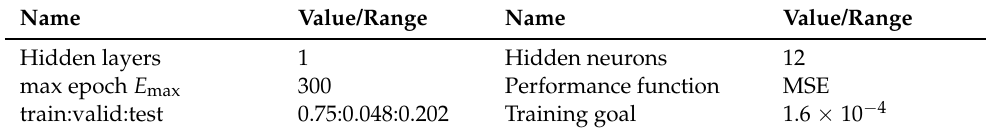
Figure 7. Collected dataset, ( a ) current in FUDS operation condition; ( b ) voltage in FUDS operation condition. Table 2. Unchanged parameters of the proposed FORNN with